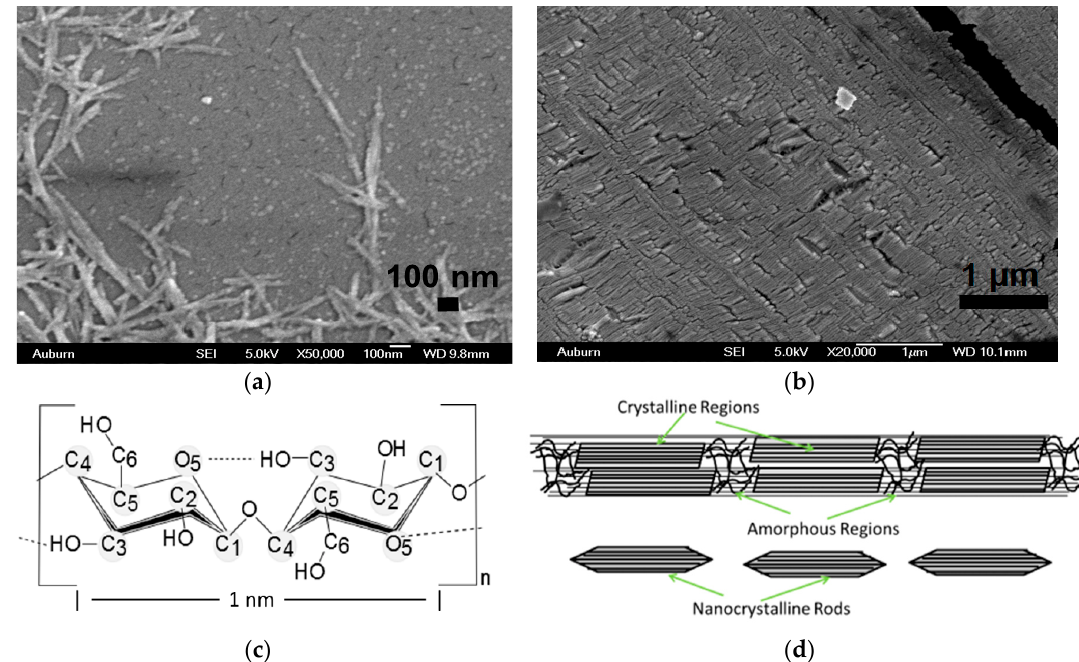
Figure 2. Scanning electron micrograph of: ( a ) individual H 2 SO 4 -based nanocrystalline cellulose (NCC) rods and, ( b ) PEO electroactive polymers (EAPs) with 5.0 wt.% LP and 7.5 vol.% NCC; ( c ) cellulose molecule; ( d ) representation of whole cellulose fiber and resulting nanocrystalline rods after sulfuric acid hydrolysis.